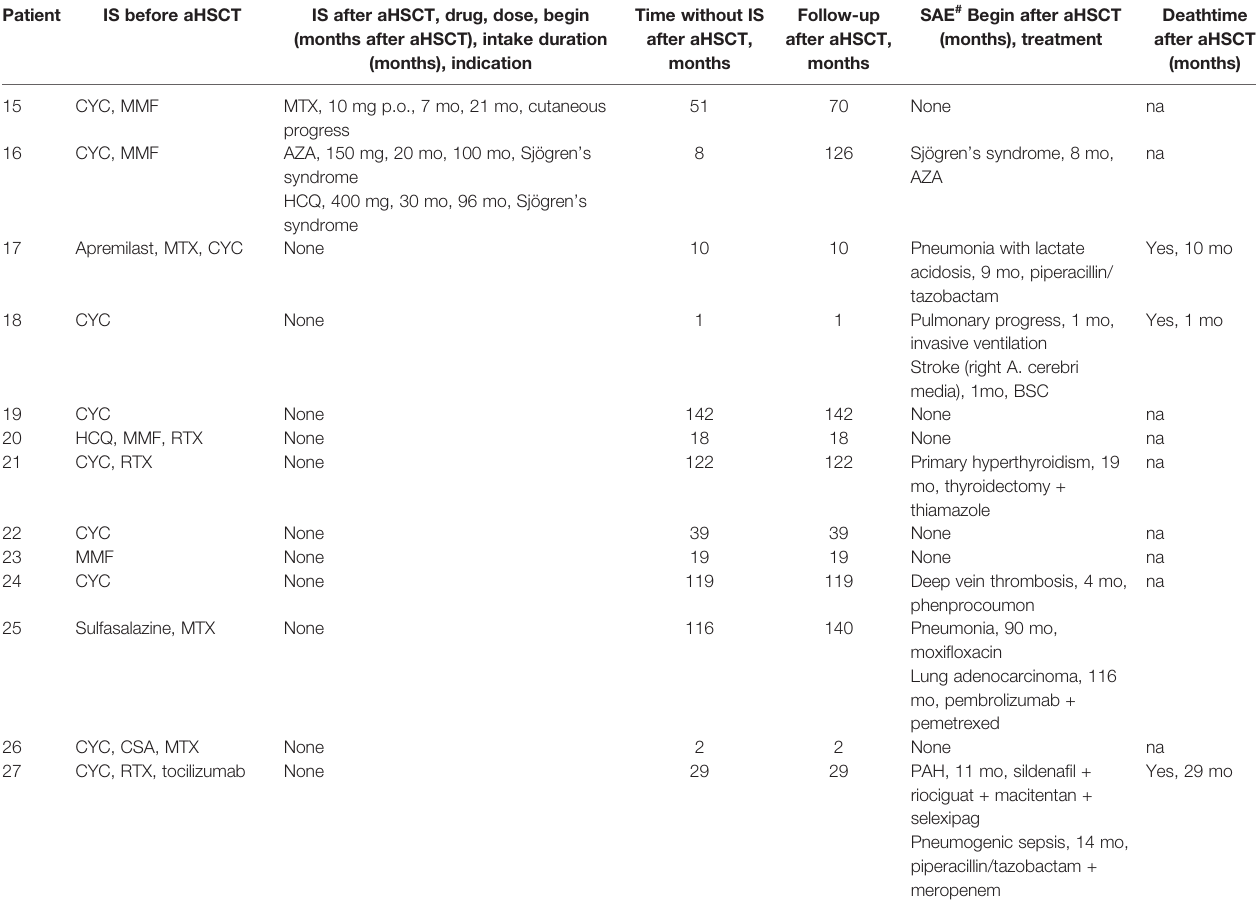
aHSCT,autologoushematopoieticstemcelltransplantation;BSC,bestsupportivecare;CSA,ciclosporineA;CPPD,calciumpyrophosphatecrystaldeposition;CYC,cyclophosphamide; HCQ, hydroxychloroquine; IS, immunosuppression; MMF, mycophenolate; mo, months; MTX, methotrexate; na not, applicable; PAH, pulmonary arterial hypertension, p.o., per os; RTX, rituximab; s.c., subcutaneous; uk, unknown. # SSc progress is listed in the “ IS after aHSCT ” column and not in the “ SAE ”